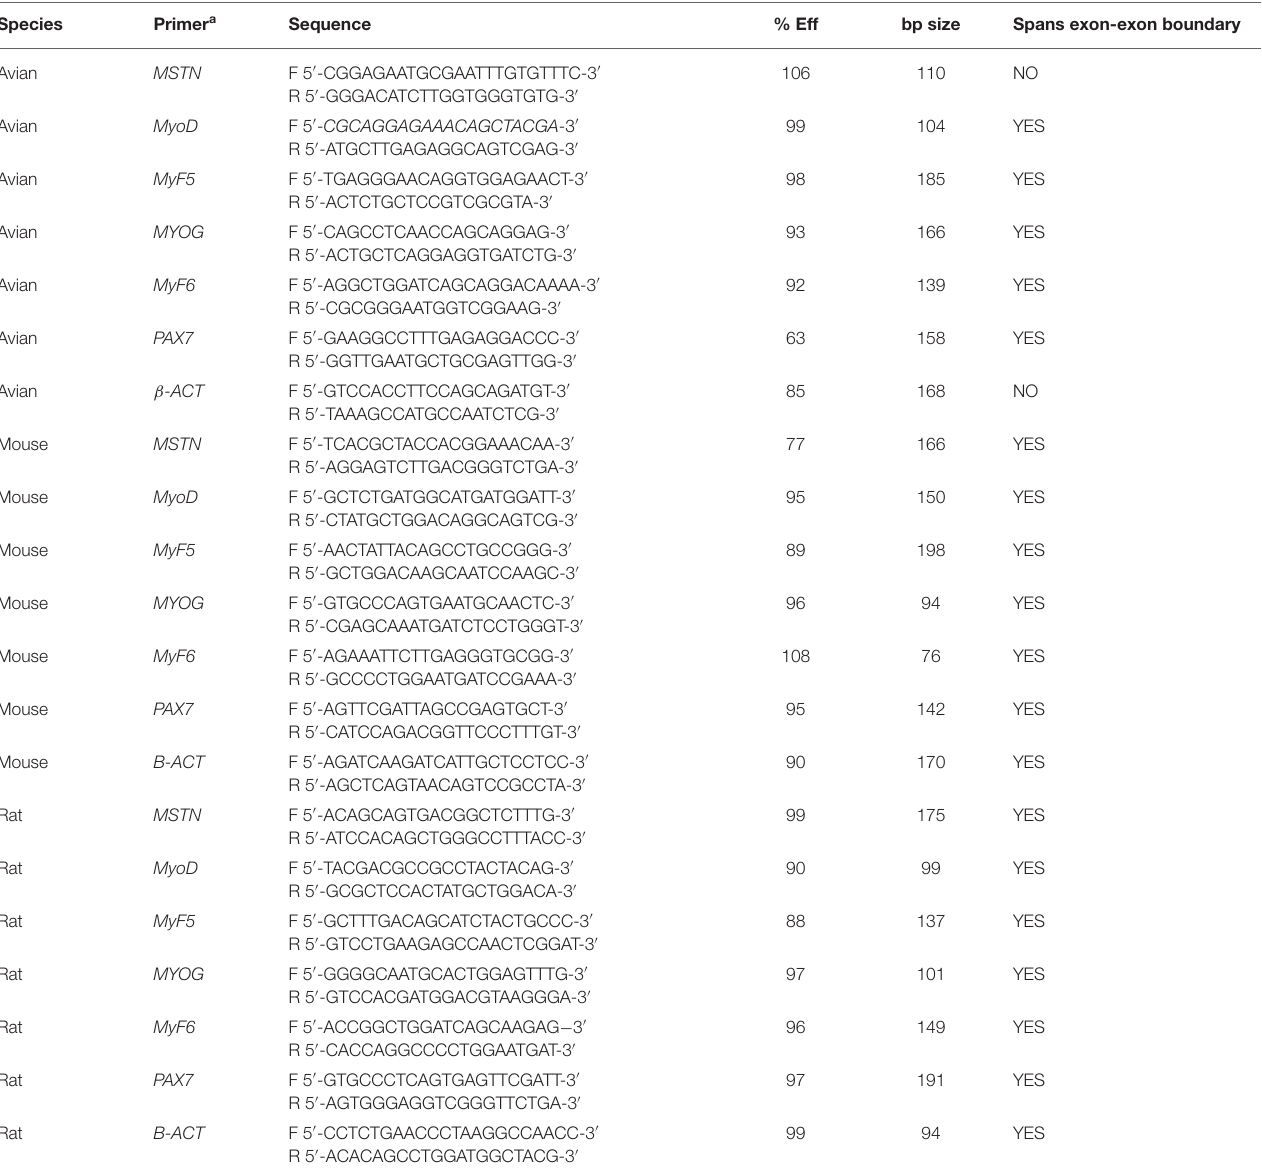
TABLE 1 | Primer sequences for real-time qPCR.